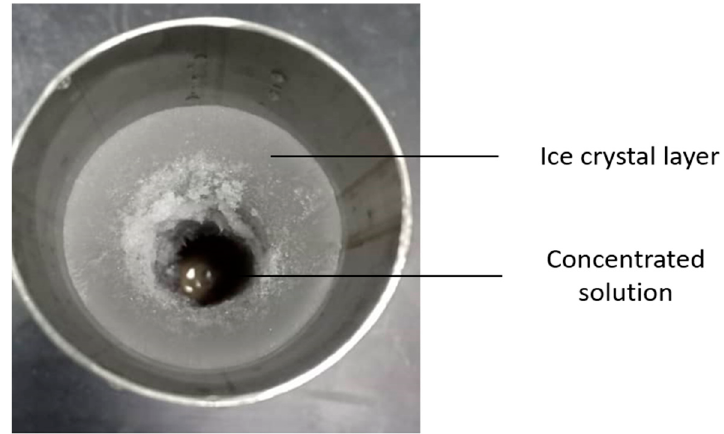
Figure 4. Top view of ice layer form at the inner wall of crystallizer.